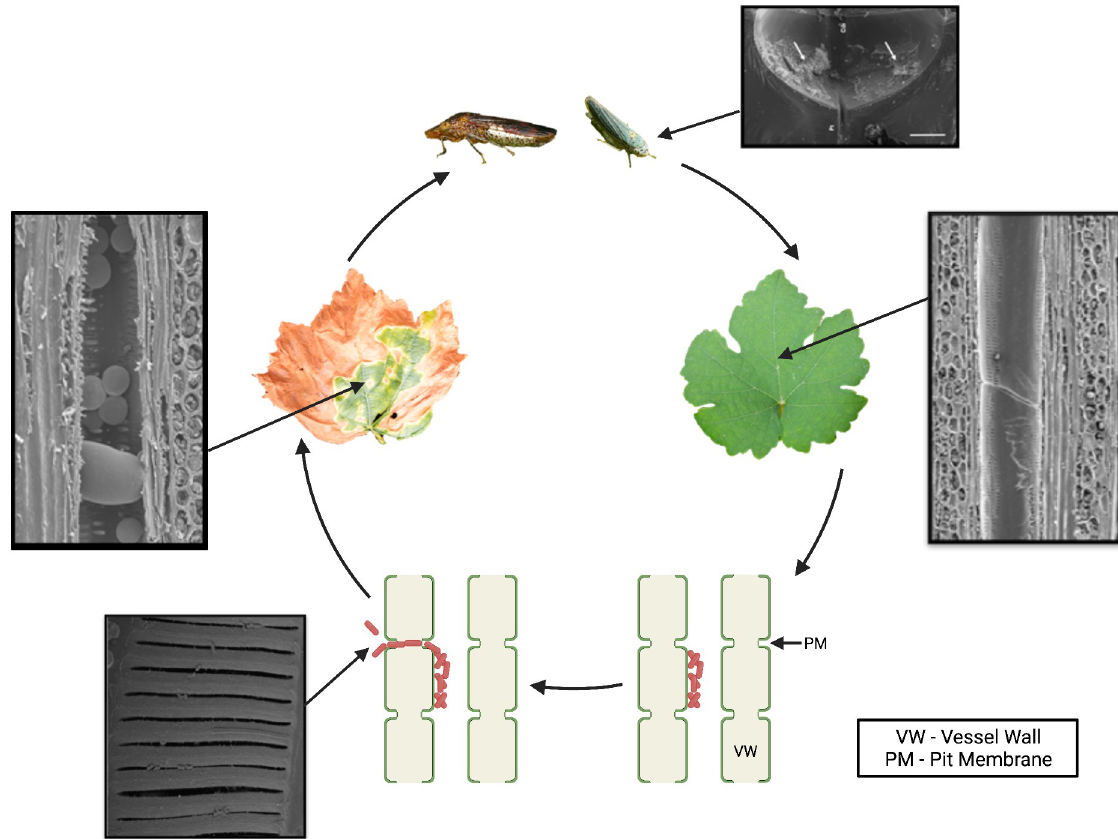
Fig 1. PD of grapevine cycle. Xylella fastidiosa is acquired by its xylem-feeding insect vectors, such as the GWSS and the BGSS, during the feeding process. Once acquired, it colonizes the insect’s foregut and forms robust biofilms (indicated by white arrows). X . fastidiosa is transmitted to a new host plant when the insect vector feeds on a new plant and deposits X . fastidiosa cells directly into the plant xylem. X . fastidiosa achieves systemic colonization of the xylem by enzymatic degradation of the xylem pit membranes that connect adjacent xylem vessels. X . fastidiosa colonization induces prolific production of balloon-shaped defense-related protrusions called tyloses in the xylem. Systemic colonization and vessel occlusion by bacterial biofilms and excess tylose production lead to PD symptom development. Photo credit for the BGSS : Rodrigo Krugner . Photo credit for the xylem longitudinal sections : Qiang Sun . Pit membrane photo reprinted from Ingel et al ., 2019 , Molecular Plant-Microbe Interactions Vol . 32 , No . 10 : 1402 – 1414 . Insect foregut image reprinted from Rapicavoli et al ., 2015 , Applied and Environmental Microbiology Vol 81 , No . 23 : 8145 – 8154 . Created with BioRender.com. B AU : AnabbreviationlisthasbeencompiledforthoseusedthroughoutFig 1 : Pleaseverifythatallentriesarecorrect : GSS, blue-green sharpshooter; GWSS, glassy-winged sharpshooter; PD, Pierce disease; PM, pit membrane; VW, vessel